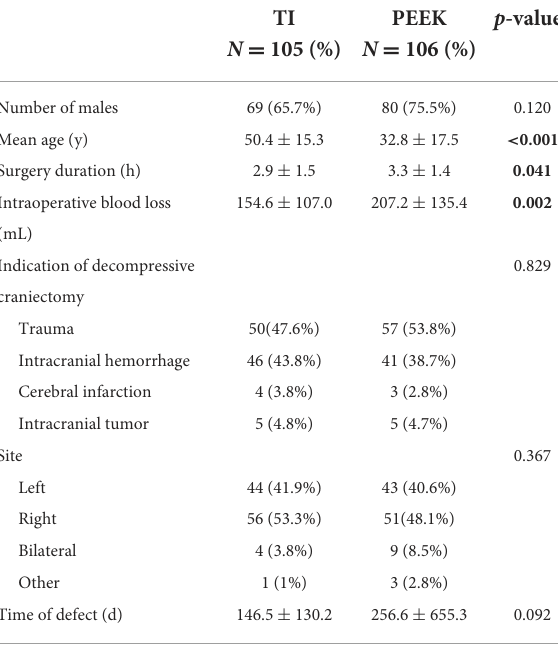
TABLE 2 Complication after decompressive craniectomy between TI group and PEEK group.